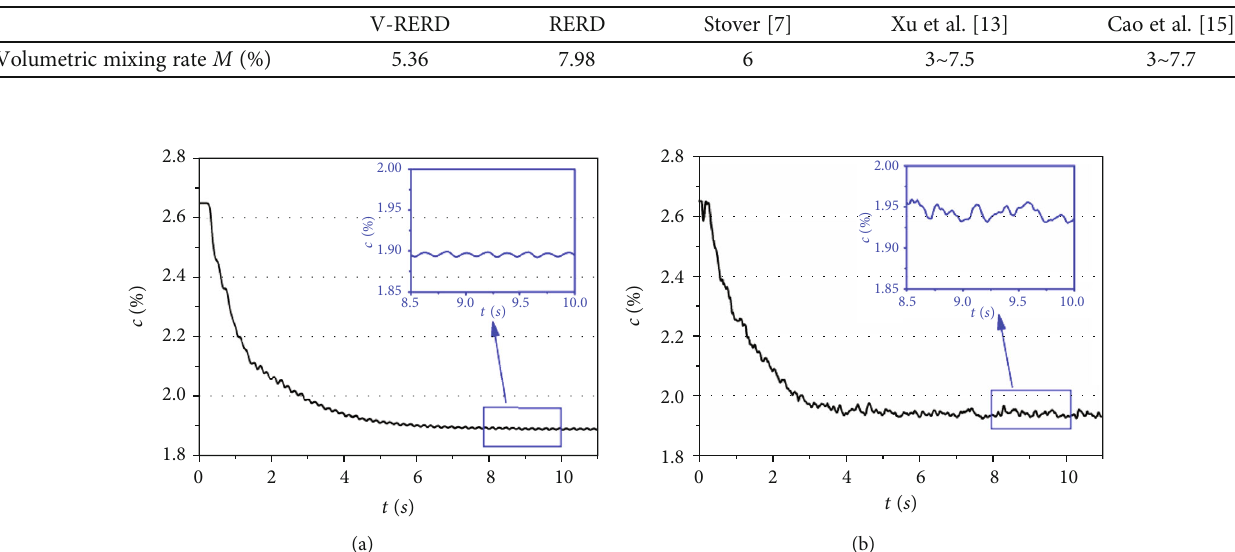
Figure 6: Comparisons of salinity concentration variations in HP outlet: (a) V-RERD and (b) RERD.